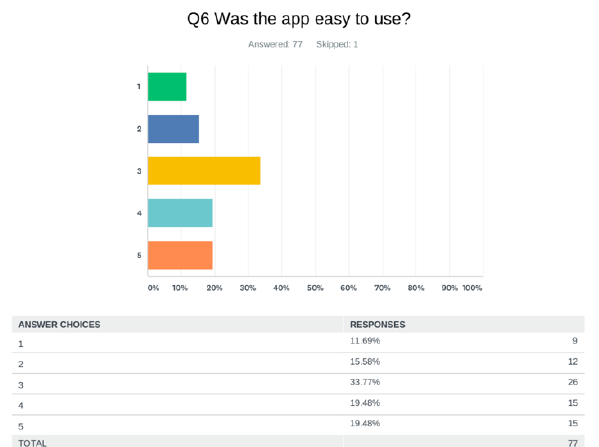
Figure 20 . Overall Summary, Question 6